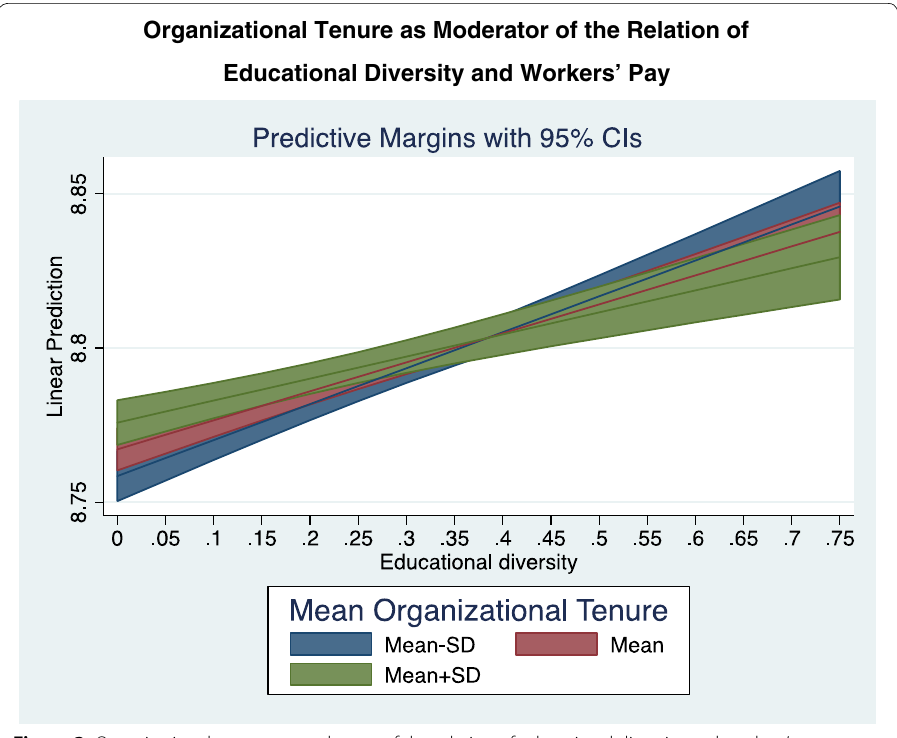
Figure 3 Organizational tenure as moderator of the relation of educational diversity and workers’ pay. Source: Authors’ calculations with data from the